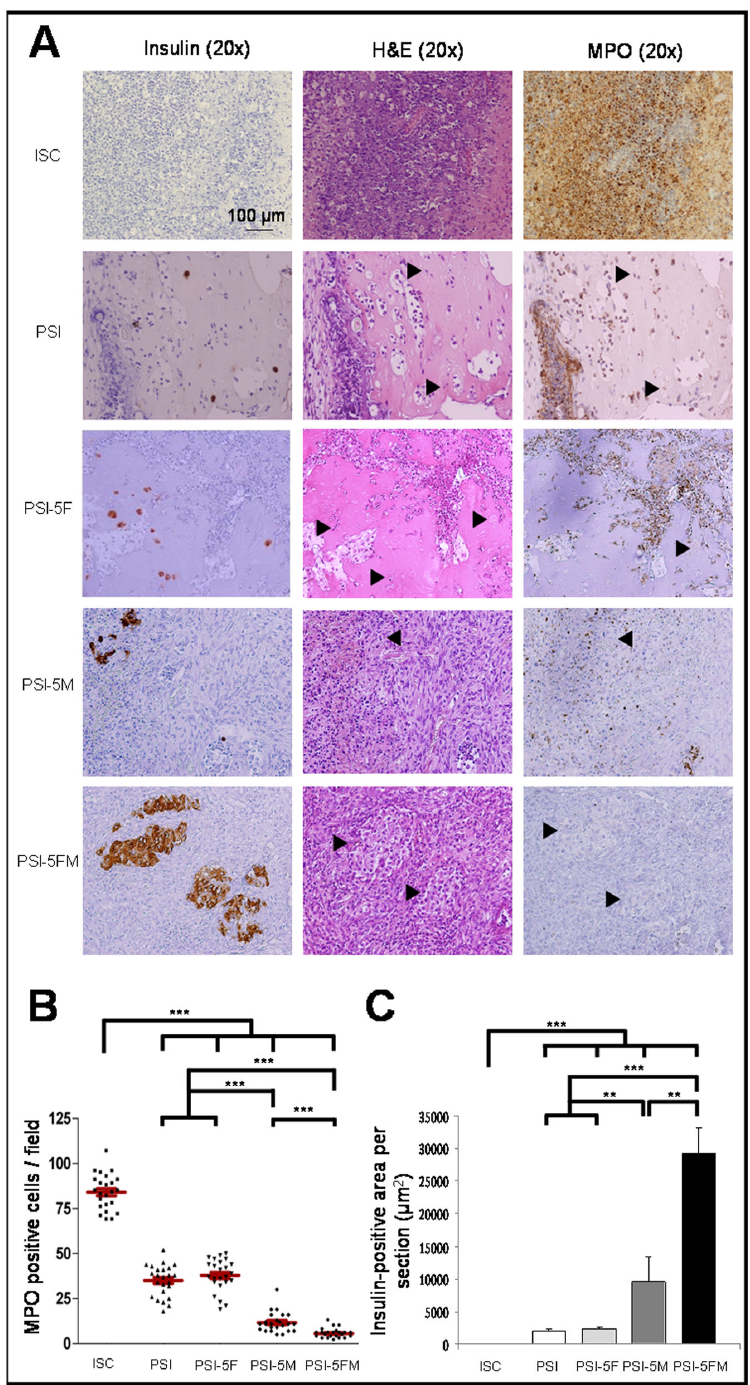
Figure 4. Histology of subcutaneous islet xenografts in immunocompetent diabetic mice. A) Representative images of subcutaneously transplanted islets alone (ISC), PSI without cells and PSI containing: 10 6 autologous fibroblasts (PSI-5F), 10 6 allogenic BM-MSCs (PSI-5M), or 10 6 of both autologous fibroblasts and allogenic BM-MSCs (PSI-5FM). Islet grafts were retrieved seven days after transplantation in diabetic mice. Samples were stained with H and E, or labelled with anti-insulin or anti-MPO antibodies. Black arrows point to islets. B) Quantification of the number of MPO-positive cells per field present on the leukocyte infiltration of the islet graft. C) Quantification of the insulin-positive area per section present on the islet graft. (**) p<0.01; (***) p<0.001. doi: 10.1371/journal.pone.0073526.g004 PLOS ONE |